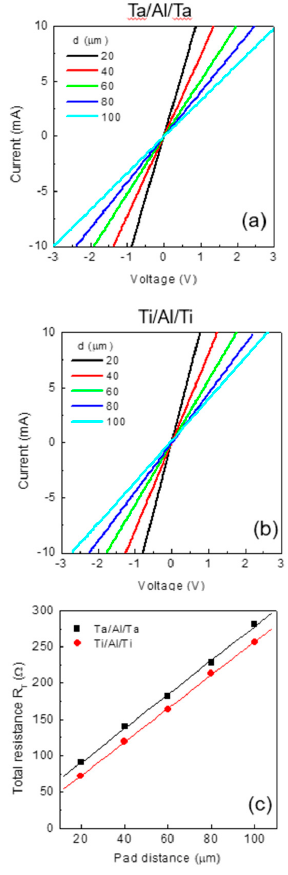
Figure 2. I–V curves acquired on TLM structures in ( a ) Ta / Al / Ta and ( b ) Ti / Al / Ti contacts annealed at 600 °C. ( c ) Characteristic plot of the total resistance R TOT measured as a function of the adjacent TLM pads’ distance d for Ta / Al / Ta (squares) and Ti / Al / Ti (circles).